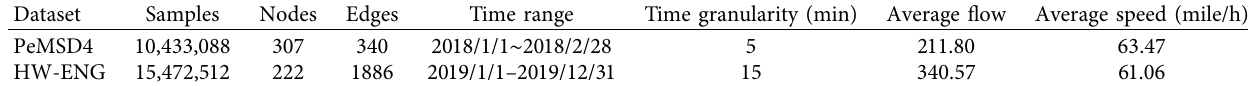
Table 1: Comparison of properties of the two